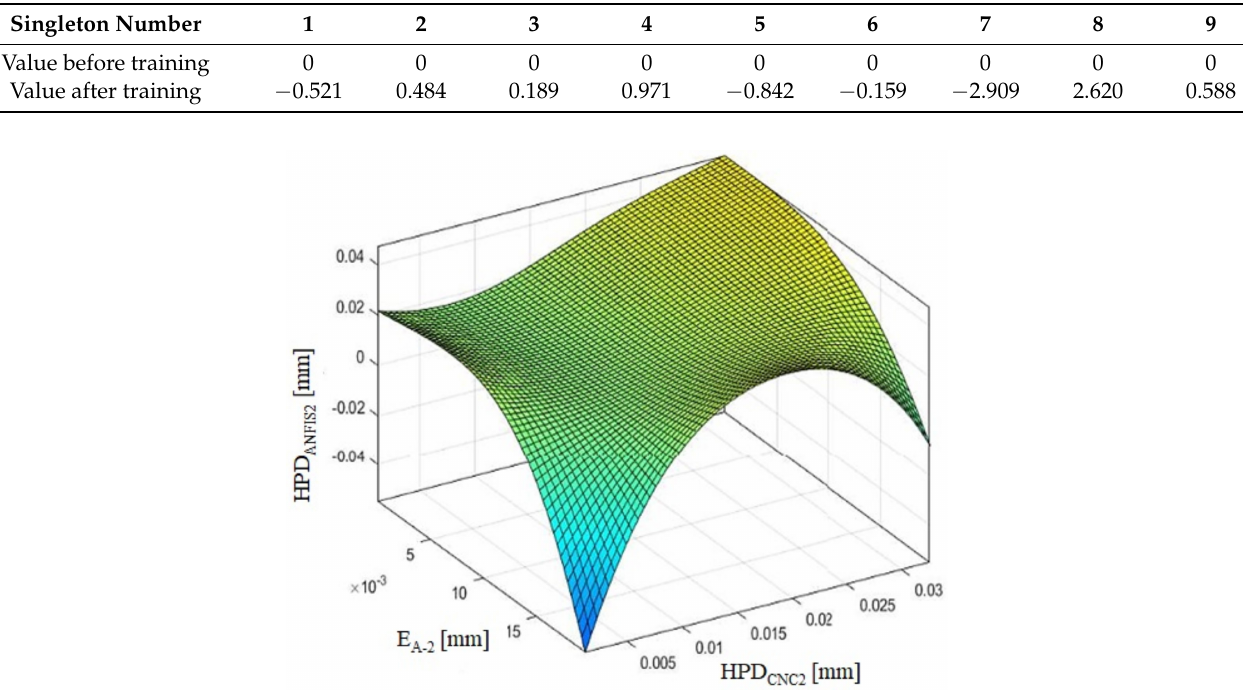
Figure 13. Surface of ANFIS model after the training